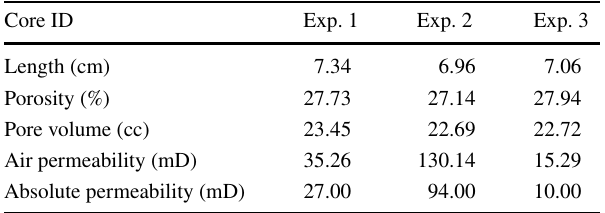
Table 2 Petrophysical properties of core samples used for oil